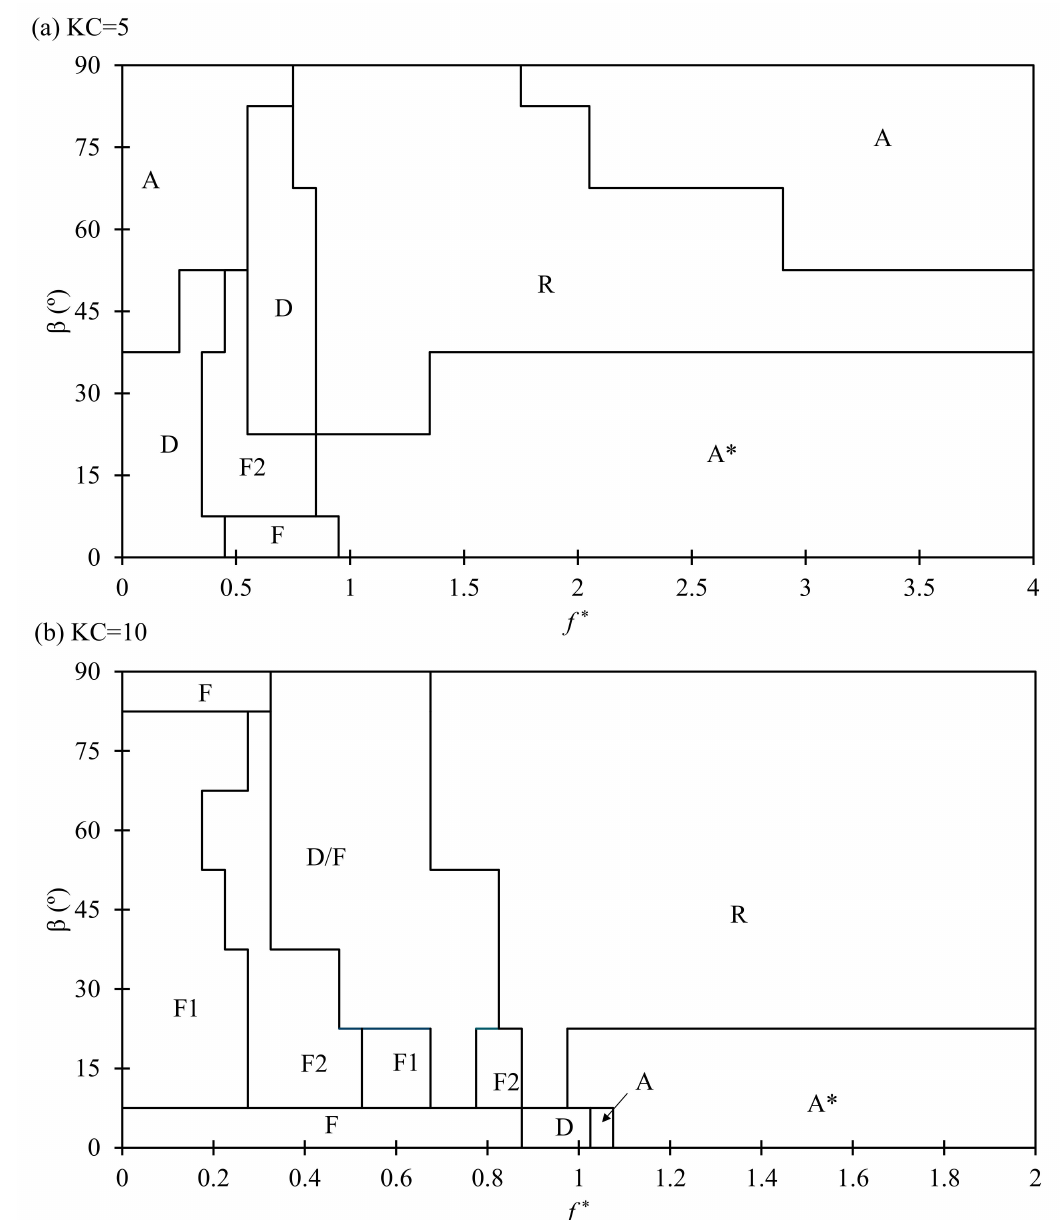
Figure 3. Flow regime maps for ( a ) KC = 5 and ( b ) KC